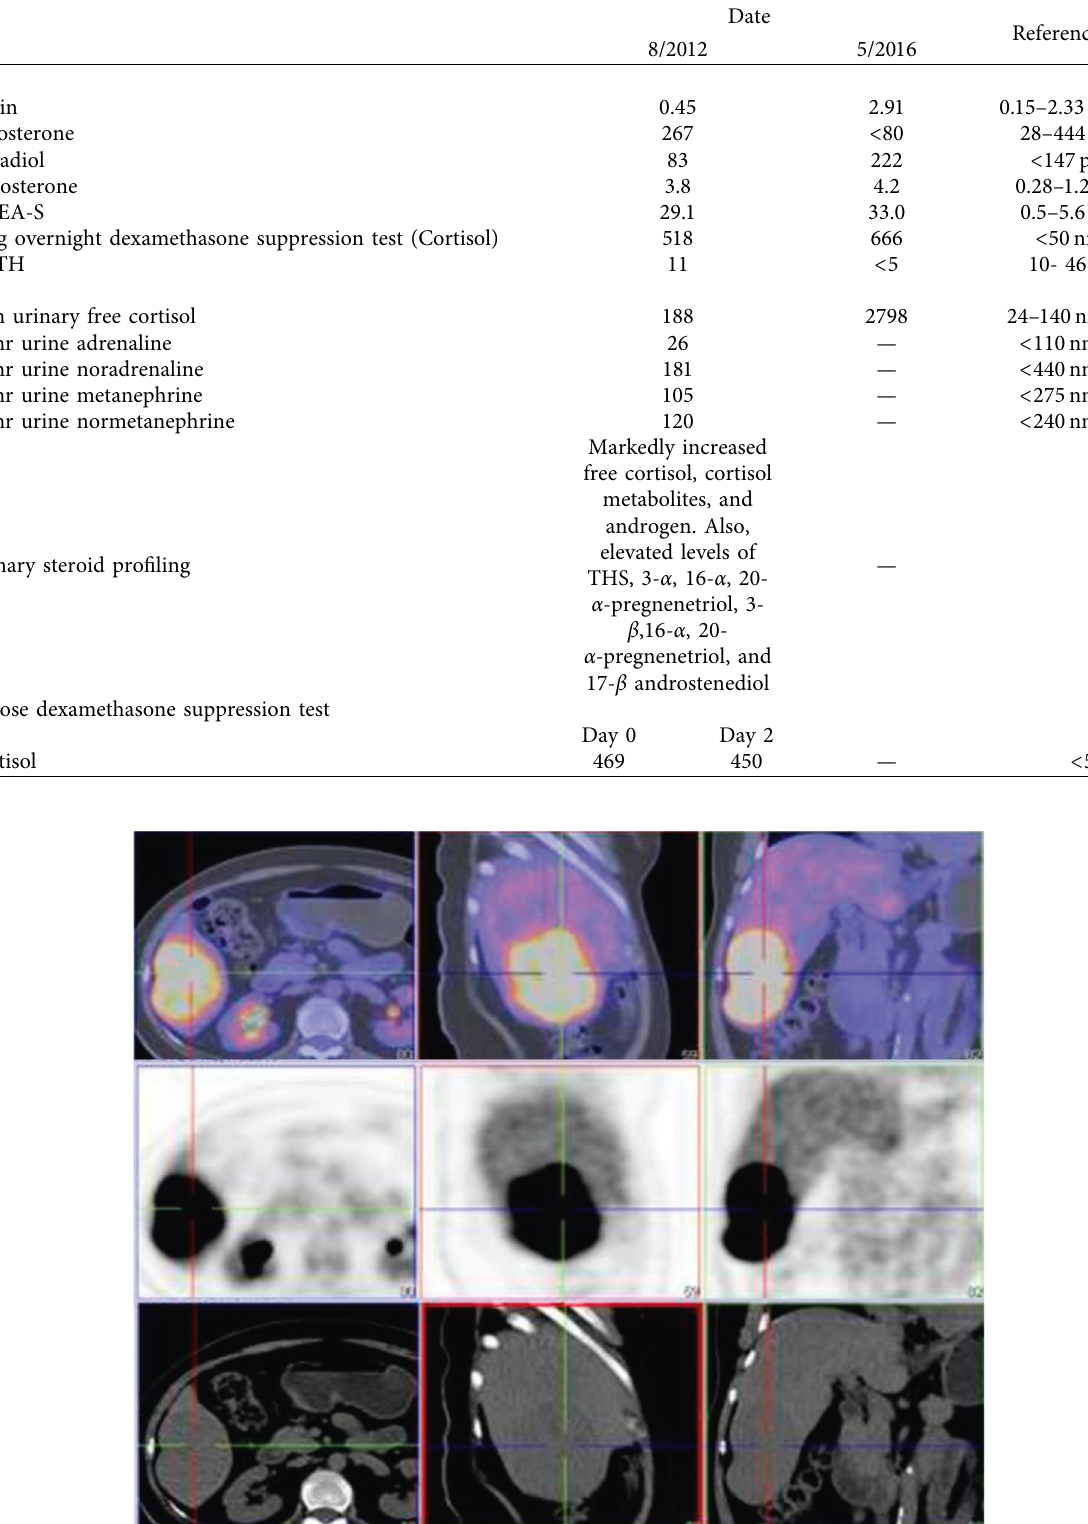
Table 1: Biochemical investigations of Patient A in 2012 and 2016.